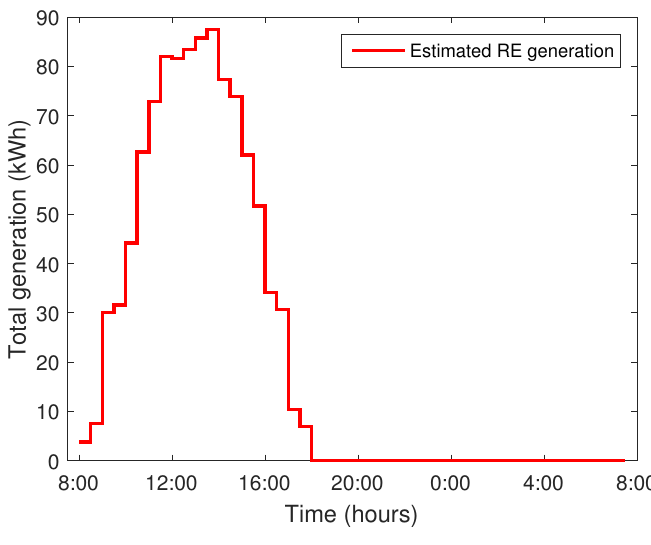
Figure 13. Estimated energy